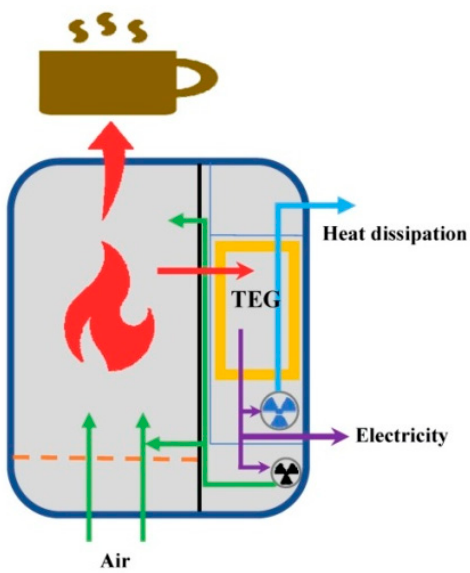
Figure 1. Diagram of a basic stove-powered thermoelectric generator (STEG).